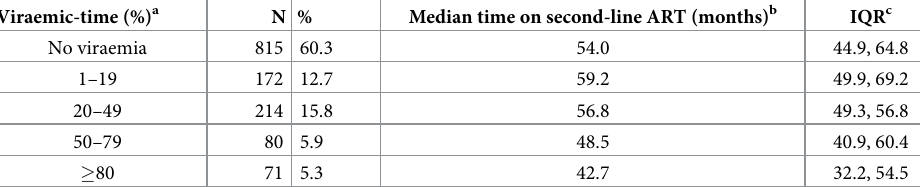
a Viraemic-time is calculated as estimated time with VL > 200 copies/mL over total follow-up time on second-line ART b Calculated from the start of second-line ART until the end of the study period or censoring (death, switch to third-